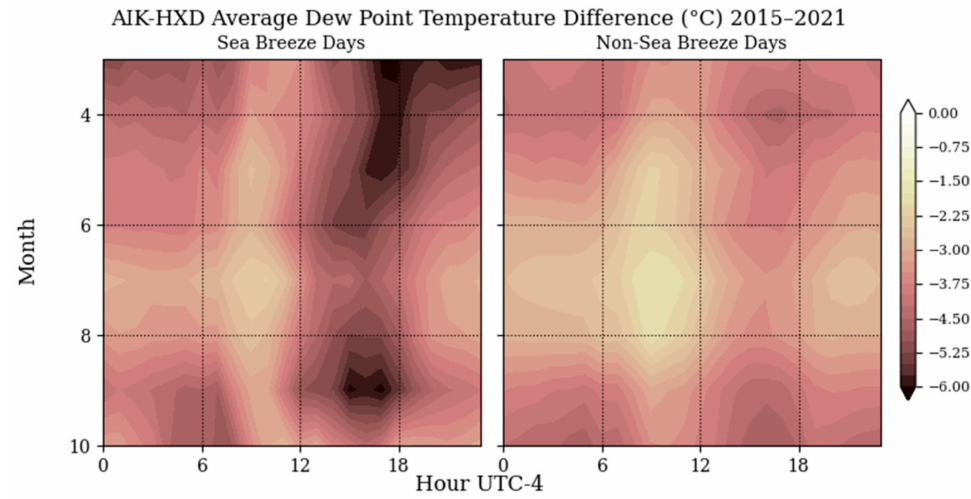
Figure 5. Differences in average hourly dew point temperature between an inland (Aiken) and a coastal (Hilton Head Island) weather